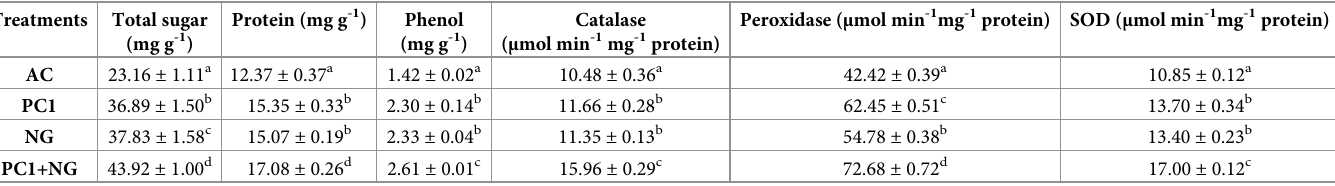
Means in each column followed by the same letter were not significantly different (P � 0.05) as determined by one-way ANOVA and Duncan’s Multiple Range Test (DMRT). Values were the means of three replications ±